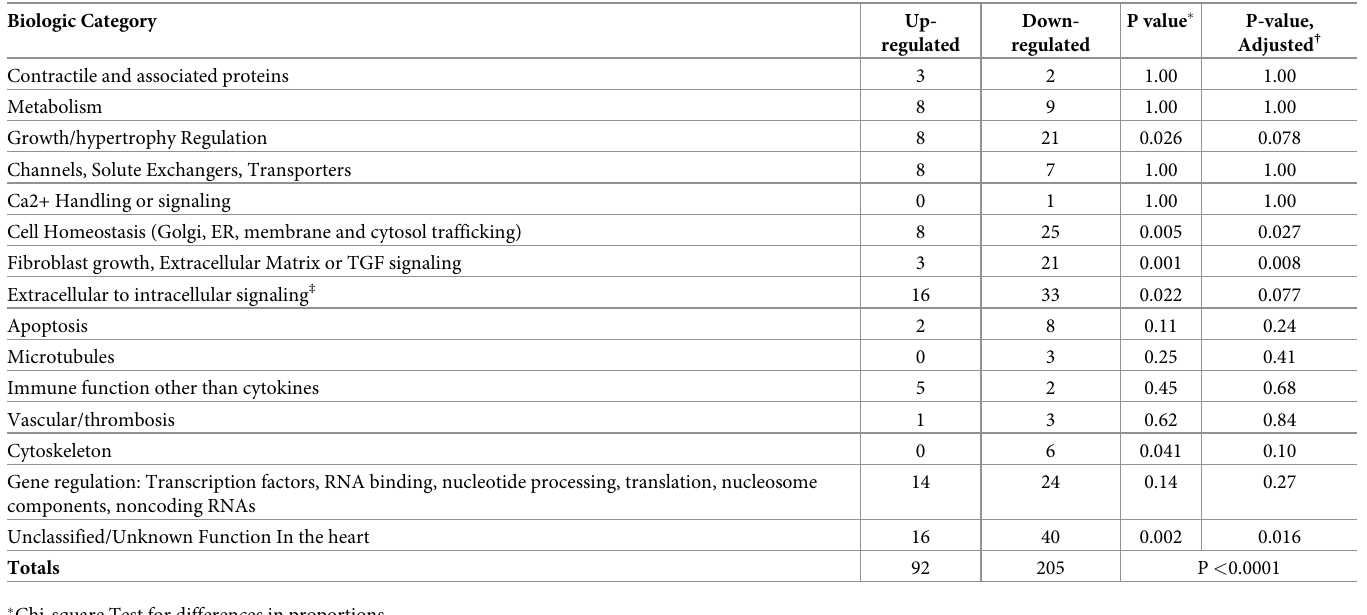
Table 4. Biologic categories of concordant global gene expression changes measured by microarray and RNA-Seq in the S-R cohort, R/NR analysis (from Table 3). Biologic